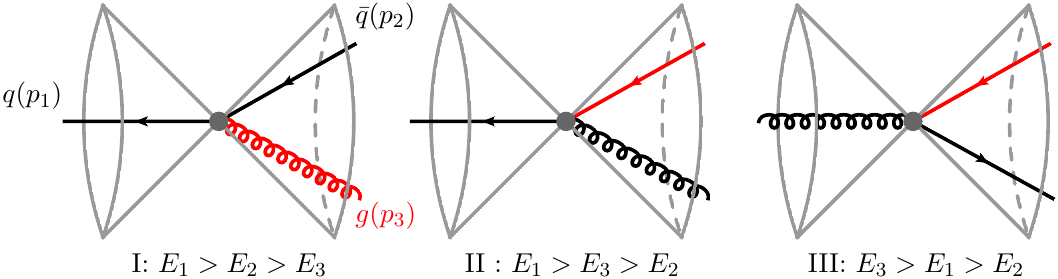
Figure 3 . Kinematical con(cid:12)gurations in the three di(cid:11)erent regions with di(cid:11)erent energy ordering. Particles with the smallest energy are drawn in